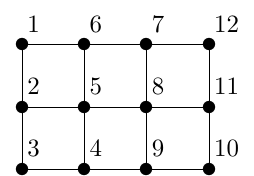
Figure 6: Prime labeling on P